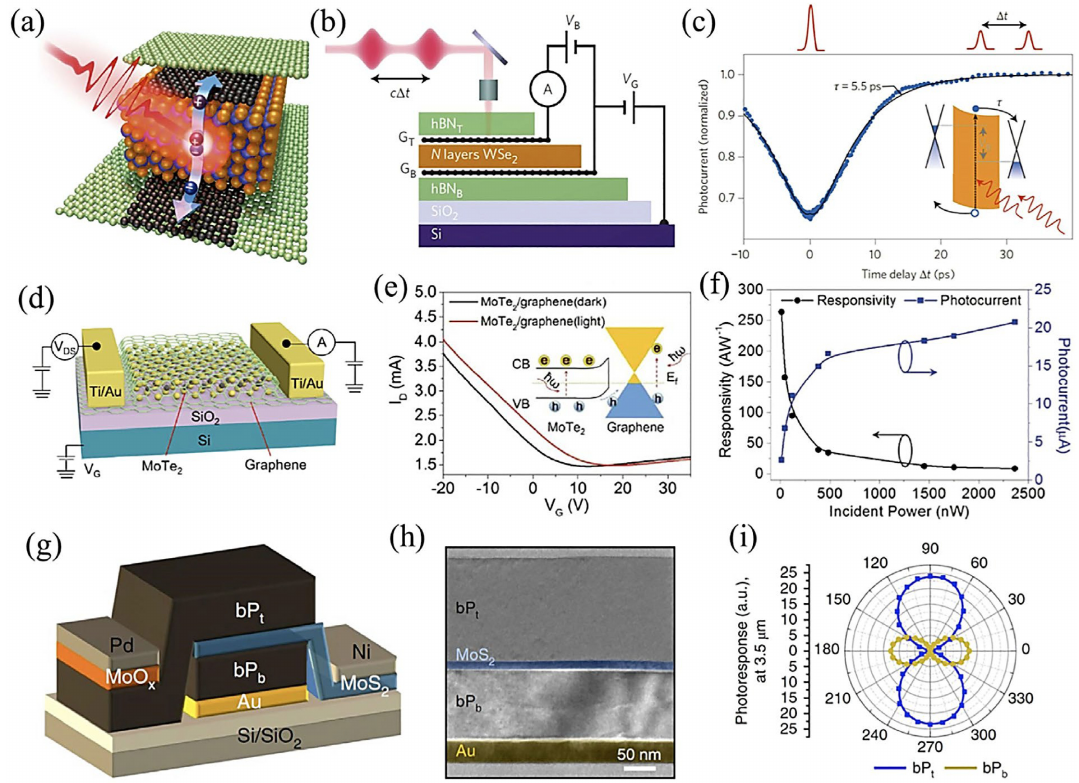
Figure 9. ( a ) Atomistic representation of photoexcited carrier dynamics in an h -BN/G/WSe 2 /G/ h -BN heterostructure. Excitons are produced, separated, and delivered to graphene electrodes under pulsed- laser excitation. ( b ) Demonstration of time-resolved photocurrent-analysis method. ( c ) Photocurrent time-delay behavior demonstrates a light response-time constant of 5.5 ps. Adapted with